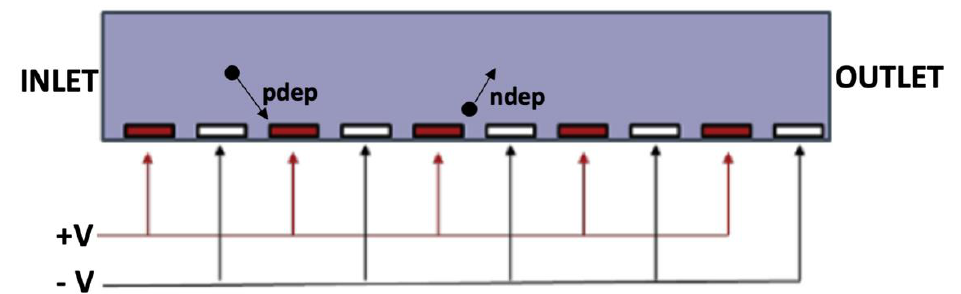
Figure 4. Side view of an interdigitated electrode channel, with indication of particle response depending on the sign of the DEP force.